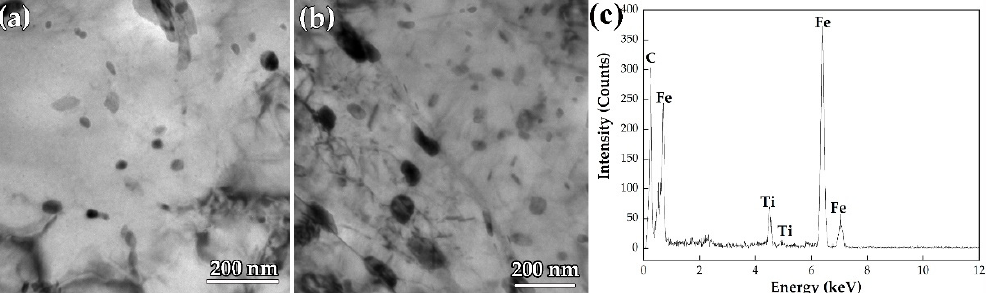
Figure 12. ( a , b ) TEM images of the precipitates obtained from surface and mid-thickness and ( c ) the corresponding EDS of steel B plate.